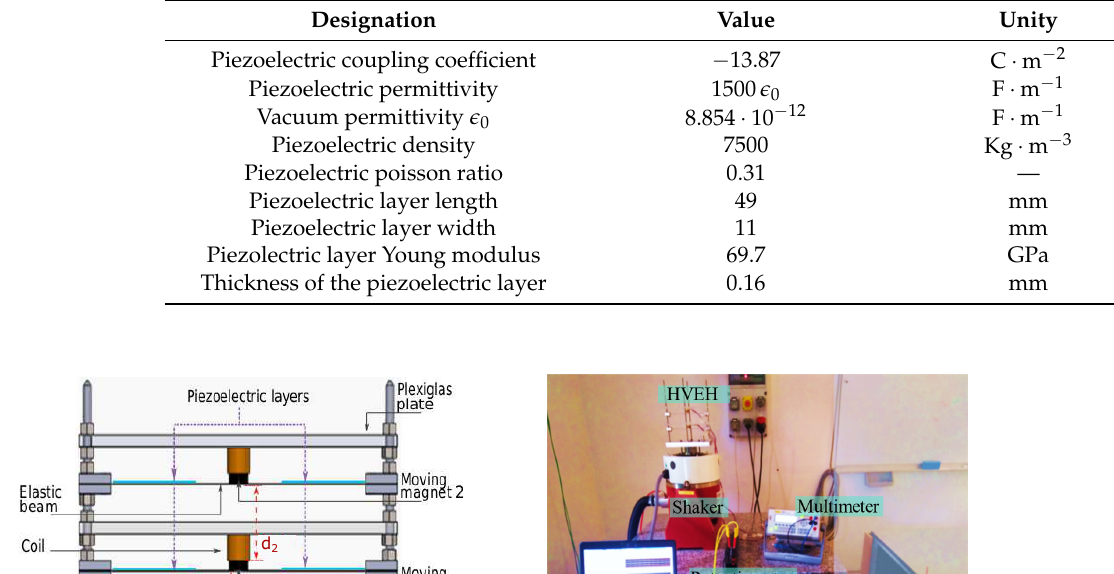
Table 2. Design parameters of the piezoelectric patches.